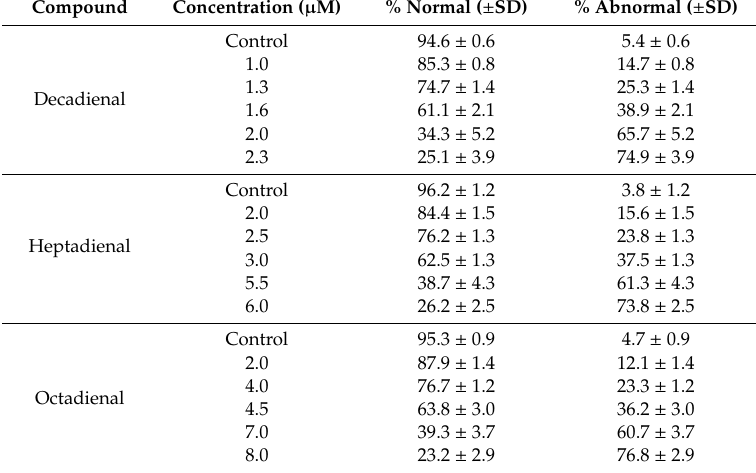
Table 1. Percentage of Paracentrotus lividus embryos with normal and abnormal development after the three polyunsaturated aldehyde (PUA) treatments. Results were obtained by morphological analysis at 48 hpf; at least 200 pluteus larvae were